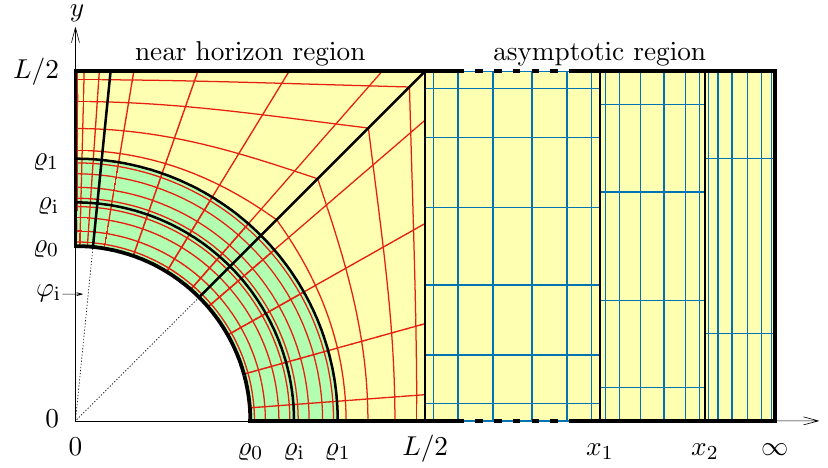
Figure 5 . Grid structure for the construction of localized black hole solutions. For x computations are carried out with respect to the near horizon chart (2.5) (indicated by red grid lines) while for x L= 2 the asymptotic chart (2.2) is used (indicated by blue grid lines). For (cid:21) % % 1 (green shaded region) we de(cid:12)ne a ’ -independent reference metric that only contains powers (cid:20) of % by matching with the ten-dimensional Schwarzschild-Tangherlini metric at the horizon % = %